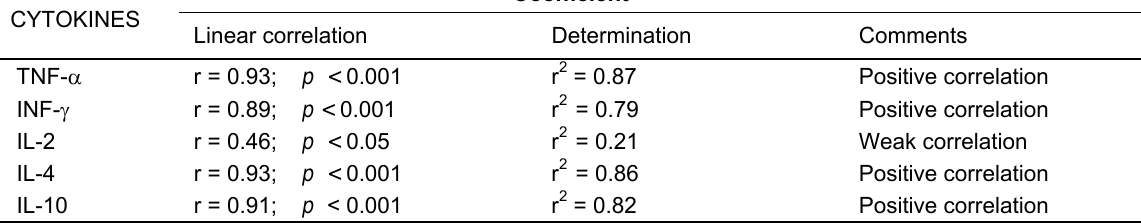
G1: 15 HIV-1 patients virgin to treatment; G2: 27 HIV-1 patients under HAART with detectable VL; G3: 31 HIV-1 patients under HAART with undetectable VL; G4: 20 normal blood donor volunteers; r: linear correlation coefficient; r 2 : determination